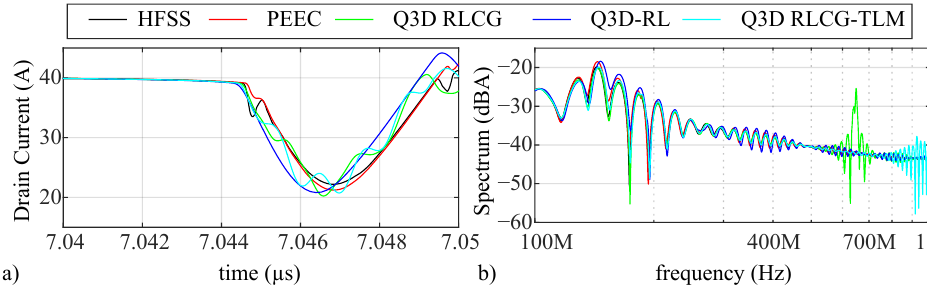
Figure 6. Detailed comparison of current waveforms shown on Figure 5: ( a ) the zoom of all wave- forms at the beginning of the switching transition, and ( b ) the spectrum of turn-off current